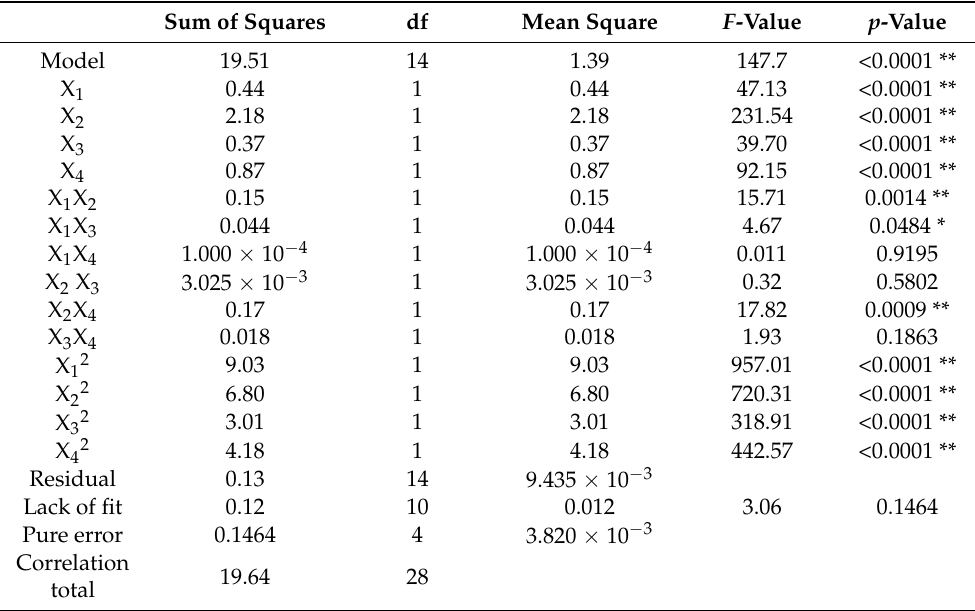
Table 2. Analysis of the variance for the fitted second-order polynomial model for deep eutectic solvent assisted extraction. Sum of